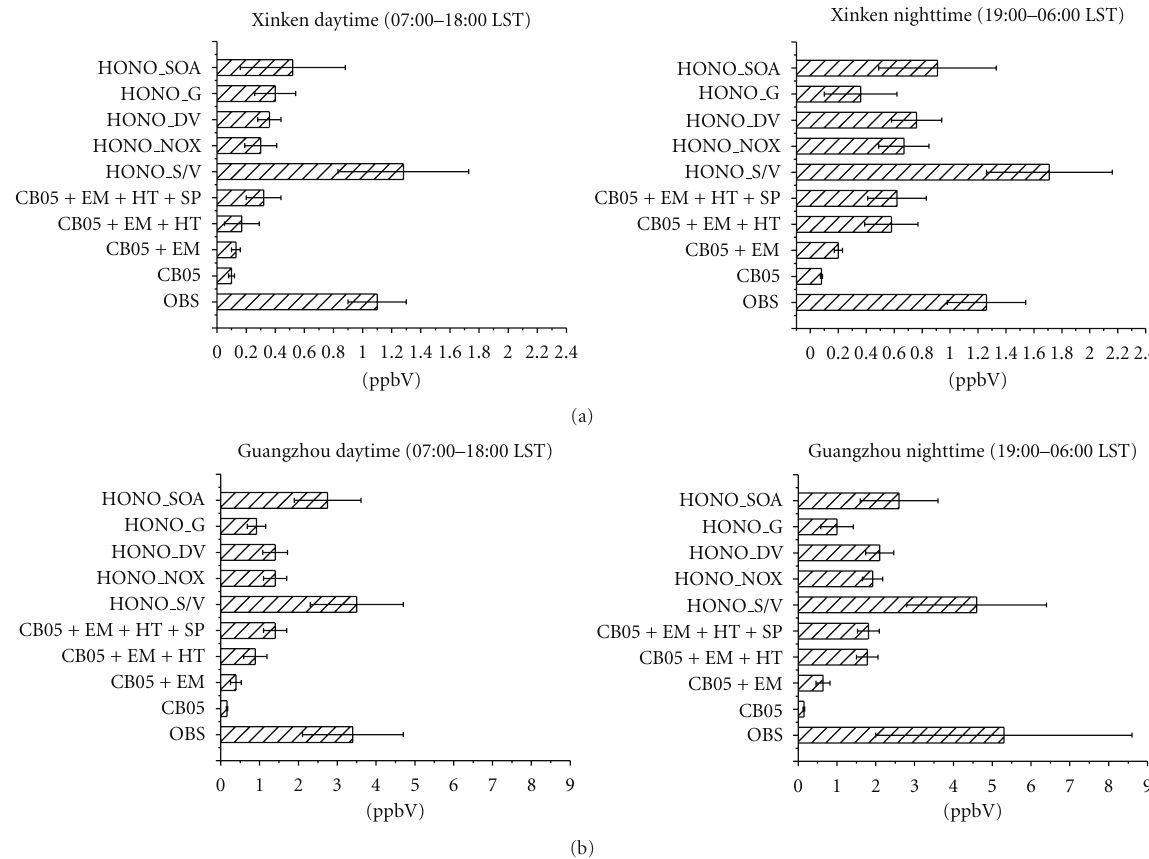
publicly available, and thus, increases in predicted mixing ratios cannot be compared with observed